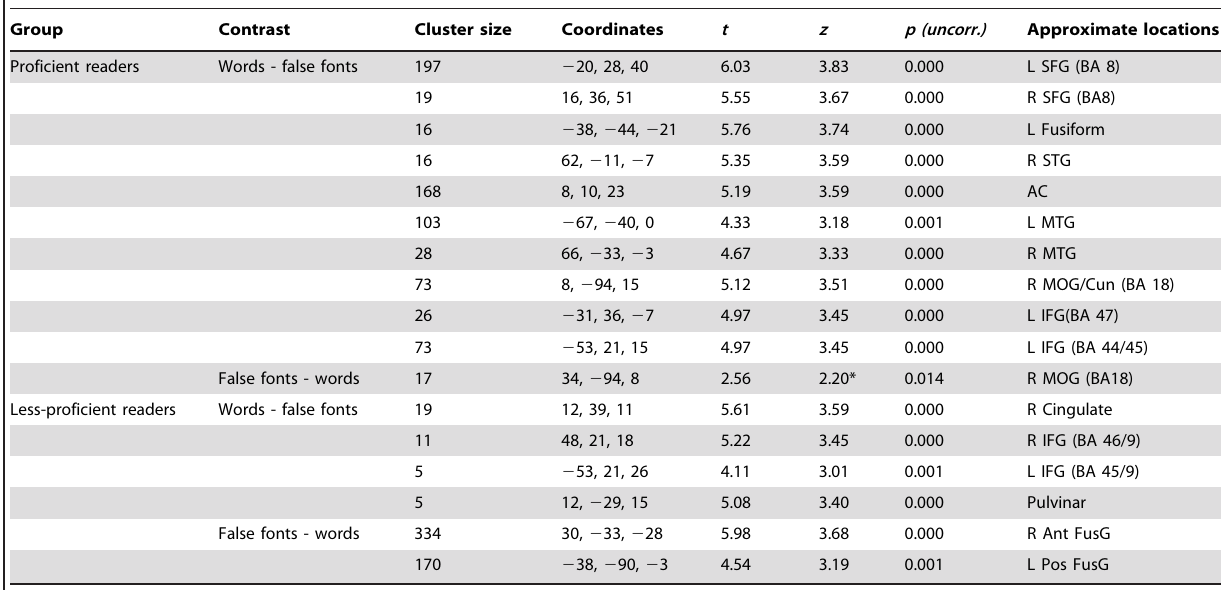
Table 2. List of all activation foci in the subgroup analyses.